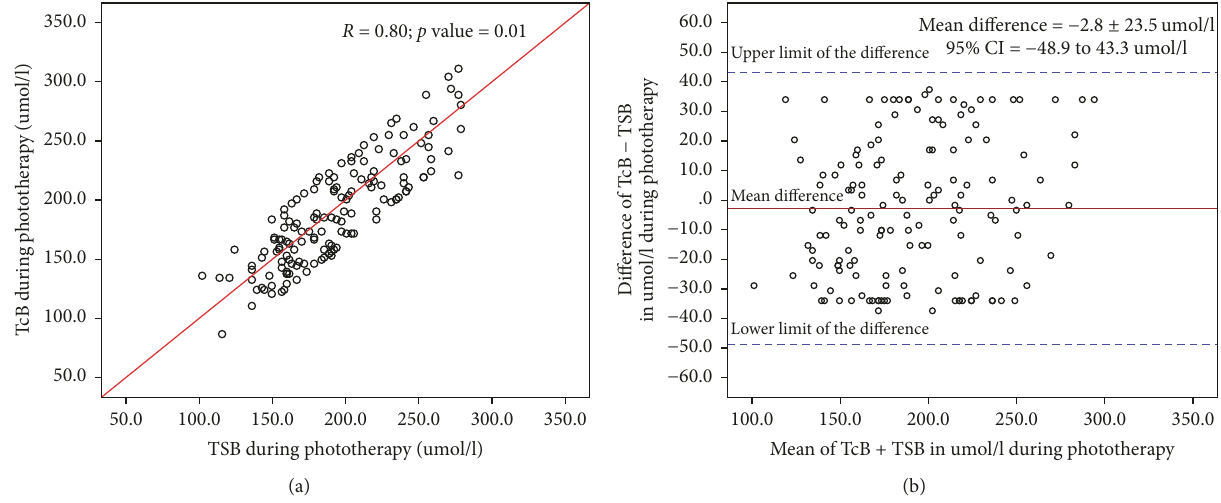
Figure 2: (a) Relationships between transcutaneous bilirubin (TcB) and total serum bilirubin (TSB) levels during phototherapy. (b) Bland- Atman Plot of transcutaneous bilirubin and total serum bilirubin values during